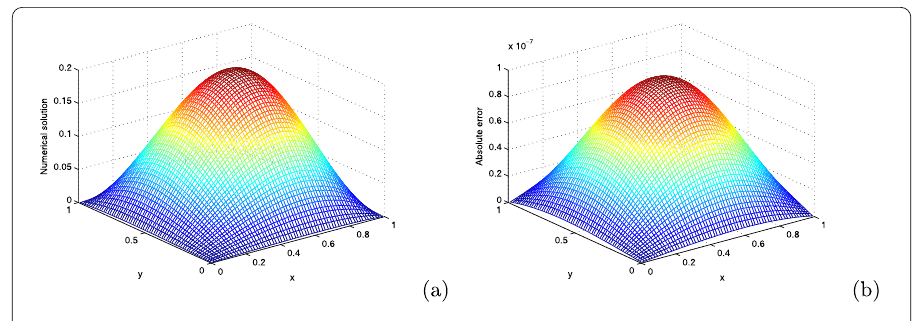
Figure 3 Numerical solution ( a ) and global error ( b ) for Example 2 with α = 0.7 at T = 1 ( h = 1/32, τ = 1/32)